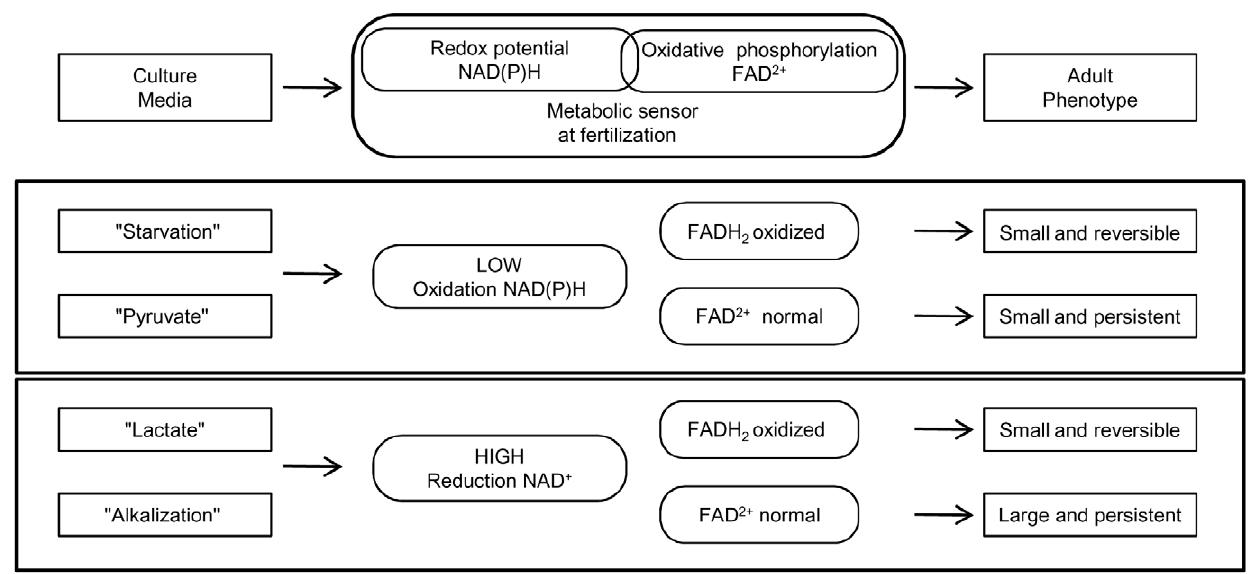
Figure 5. Post-natal outcomes resulting from zygotic metabolic sensor activities. The diagram represents the linkages between the composition of the culture media, the NAD(P)H and FAD 2 + concentrations and the adult phenotype, that are mediated by a zygotic metabolic sensor.